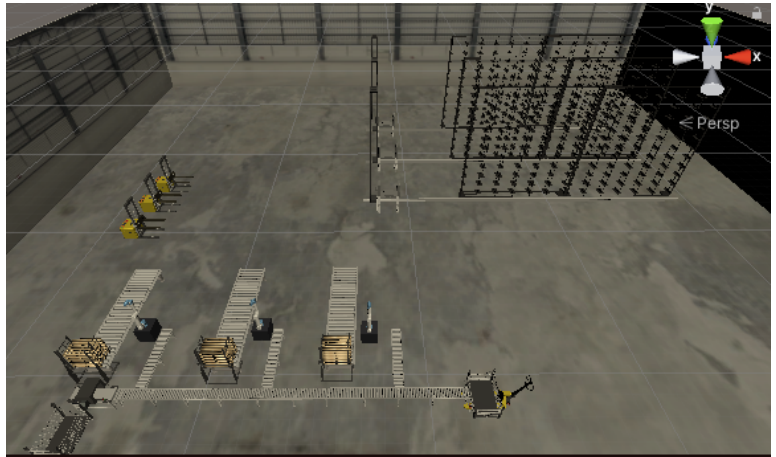
Figure 13. Three-dimensional prototype of the desired warehouse (see Figure 11) for case no.1, developed according the proposed